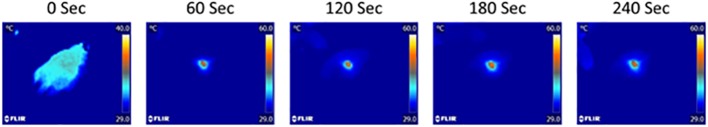
Wild type mouse was treated by CAPJ for 4 minutes.Each minute skin temperature was recorded by thermal visor. Experimental conditions: Gas flow 3 l/min, RMS voltage of 1150 V, pulse duration of 800 μs repetition rate of 487 Hz.